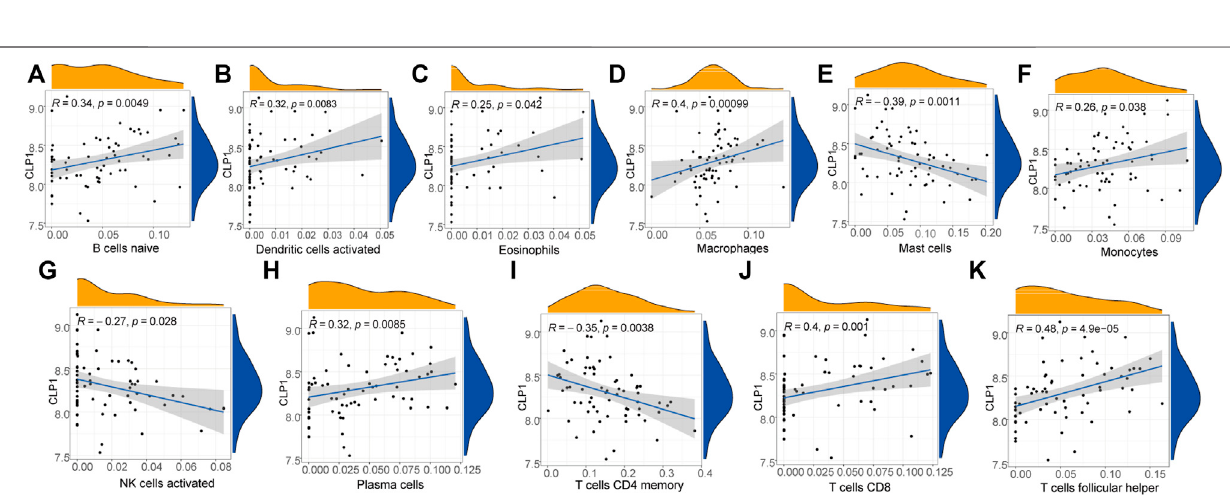
Frontiers in Pharmacology |